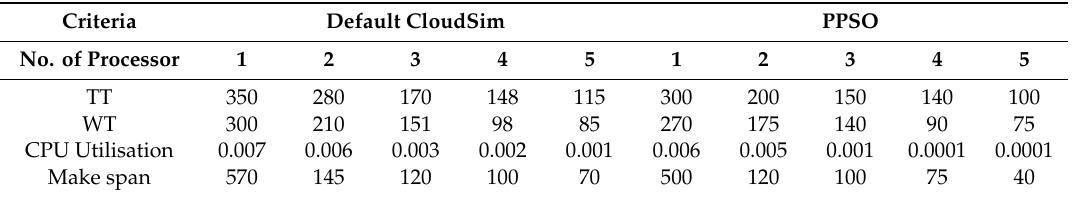
Table 11. Turnaround Time (TT), Waiting Time (WT), and CPU outputs of the PPSO algorithm on CloudSim.